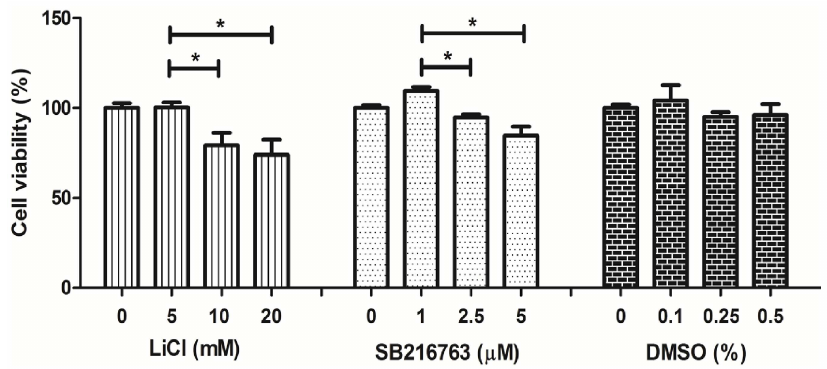
Fig 3. The toxicity effect of LiCl and SB216763 on hWJ-MSC viability. hWJ-MSCs were cultured with 0–20 mM LiCl (A) , 0–5 μ M SB216763 (B) , or 0–0.5% DMSO (C) , for 72 hrs in 96-wellplate. Then, the viability was detected by MTT assay. ** DMSO without chemical was use as vehiclecontrol. ** Datawere exposedas mean ± SD. * P < 0 . 05